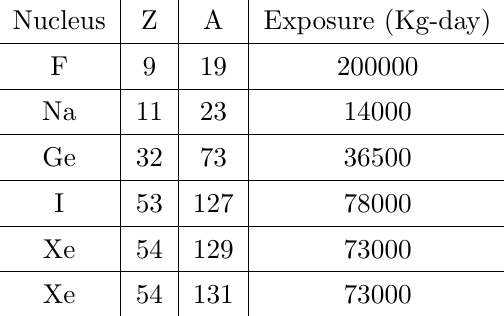
Table 2 . Mock experiments considered for the computation of di(cid:11)erential scattering event rates in this